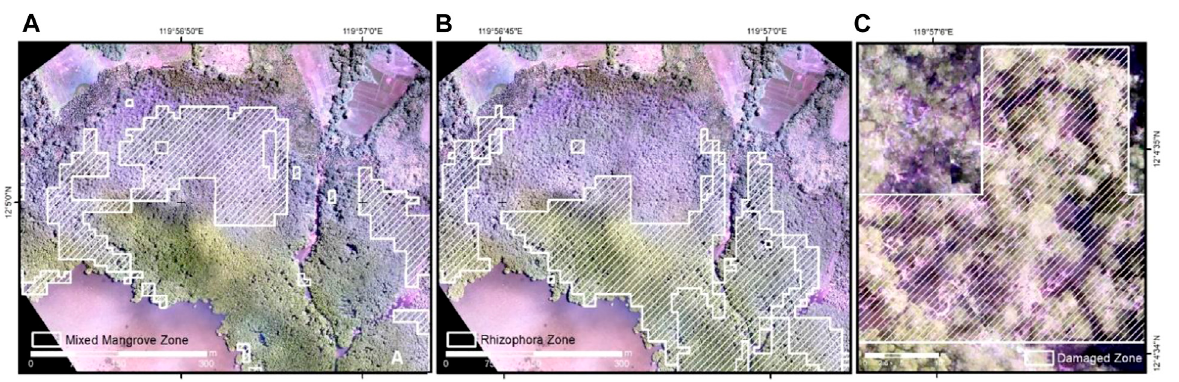
FIGURE 7 | Output mangrove zonation classes in Coron overlaid to the generated UAS orthophotos: mixed mangrove zone (A) , Rhizophora zone (B) and damaged/sparse zone (C) .